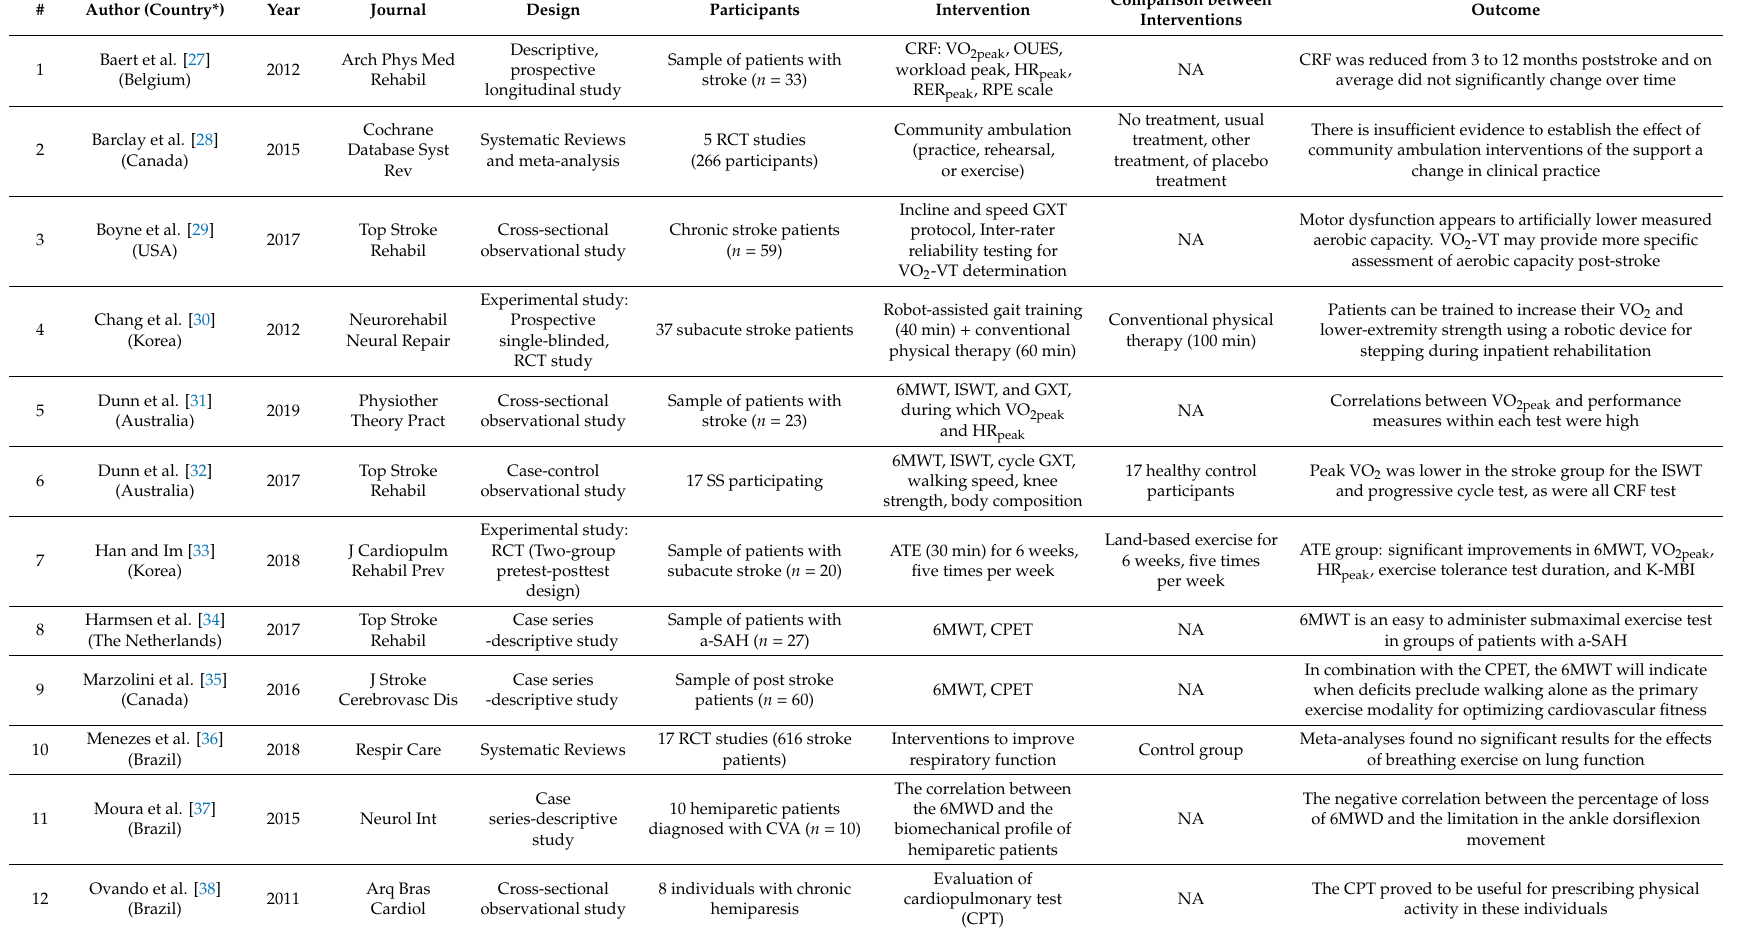
Table 5. Research characteristics selected for draft